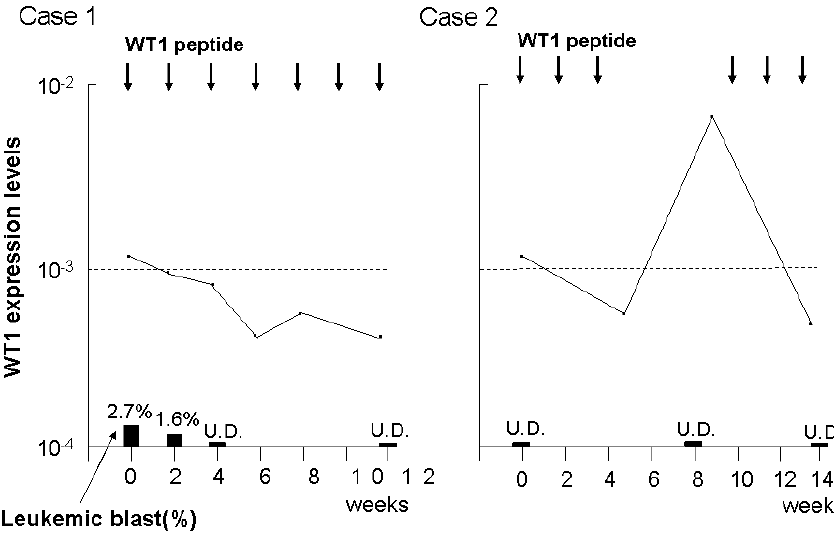
FIGURE 3. Reduction of leukemic blast cells and/or WT1 expression levels in bone marrow without leukocytopenia in de novo AML patients treated with WT1 peptide vaccination. In case 2, decrease of WT1 expression level was observed with the WT1 peptide vaccination, followed by increase of the WT1 level after cessation of the vaccination. The WT1 level decreased again after the restart of the vaccine. Correlation between the WT1 peptide vaccination and the WT1 level reduction was strongly suggested. U.D.: undetectable. This figure was modified from that in in Oka, Y. et al. (2004) Proc. Natl. Acad.